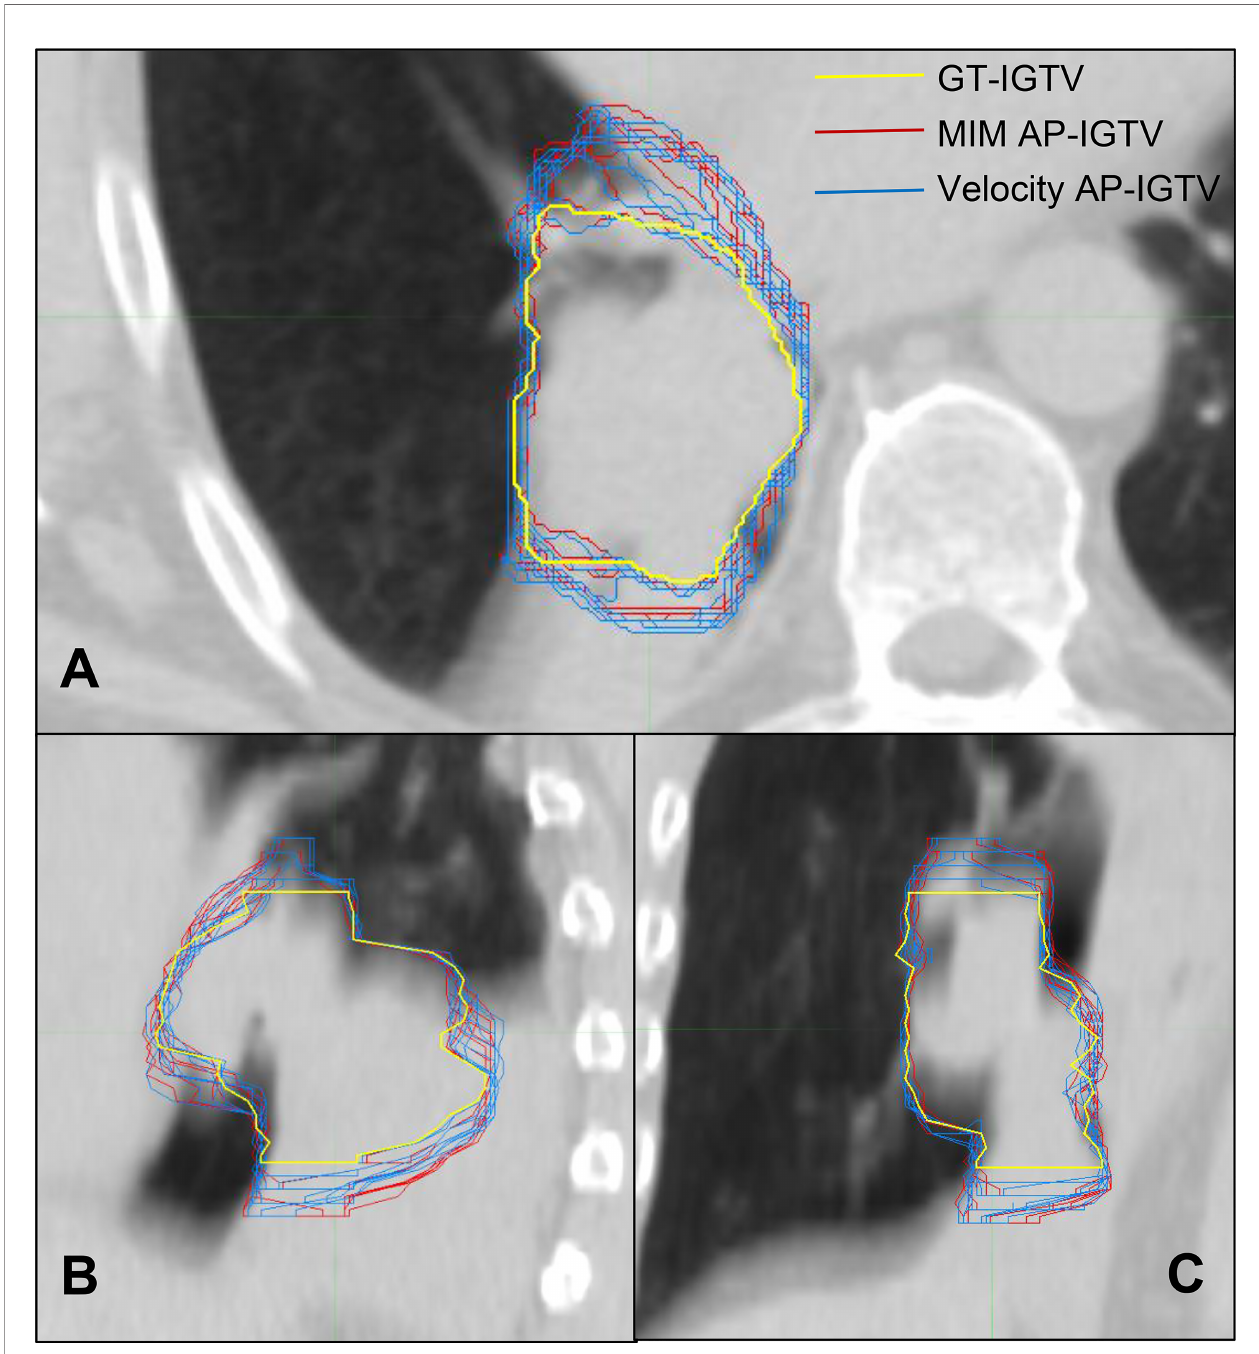
FIGURE 2 | CT cross sections of one locally advanced non-small cell lung cancer (LA-NSCLC) lesion representative of the study cohort in axial (A) , sagittal (B) , and coronal (C) planes with variation in auto-propagated internal gross tumor volumes (AP-IGTV) derived from the two employed deformable image registration (DIR) algorithms — MIM (outlined in red) and Velocity (outlined in blue) — compared to the ground-truth internal gross tumor volume (GT-IGTV; outlined in thick